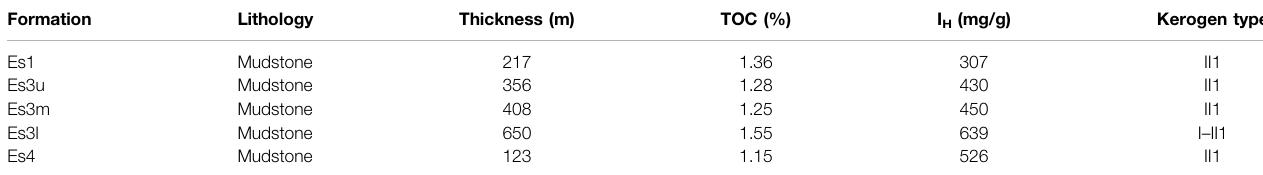
TABLE 3 | Types and content of organic matter in each of the source rocks (modi fi ed from Guo et al. (2009)). Formation